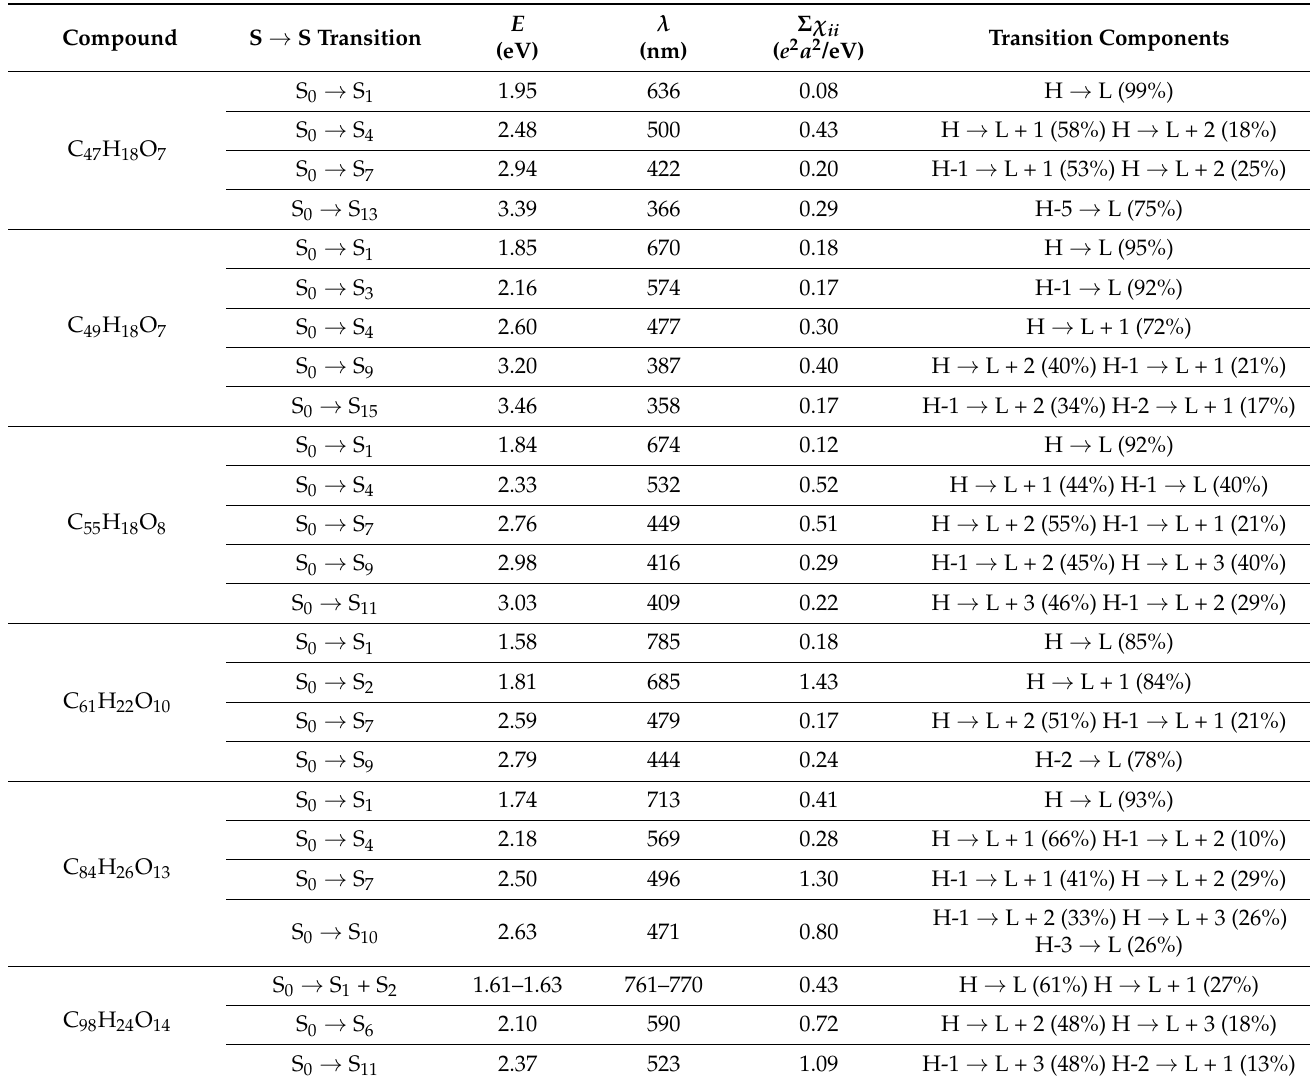
Table 1. Compound, the most intense singlet–singlet transition, photon energy, wavelength, sum of di- agonal elements of the imaginary part of dynamic polarizability and principal transition components in terms of ground-state KS orbitals (H = HOMO; L =